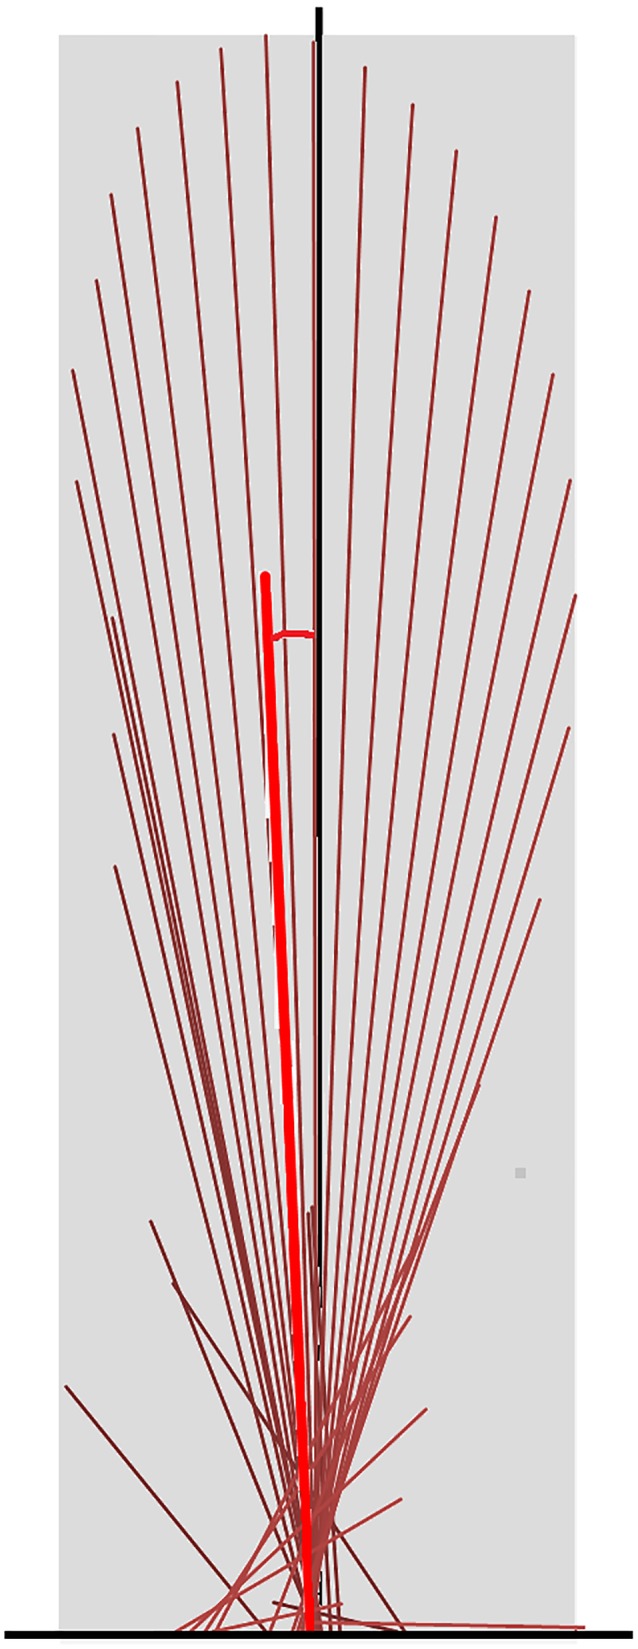
Force vector diagram for a forelimb of a horse trotting overground.Sagittal plane force vectors (dark red lines) are constructed at intervals of 8.3 ms. Each vector originates at its centre of pressure, which is identified relative to the hoof location on the force plate. The length is proportional in magnitude to that of the force and it is oriented in the direction of the force. The vector envelope (shaded area) joins the peripheral tips of the force vectors. The black vertical line is drawn through the dorsopalmar midpoint of the hoof. The summary vector is shown as a heavy red line originating at the midpoint of the hoof; its length represents the mean magnitude (VecMag) and its angle to the vertical represents the mean angle (VecAng) of all vectors throughout the stance phase.